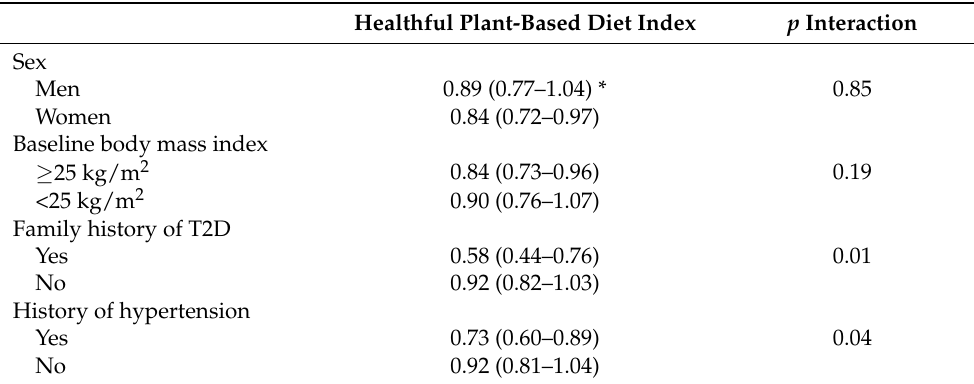
Table 4. Hazard ratios (HR) and 95% confidence intervals (CI) for incident type 2 diabetes according to the continuous hPDI score, stratified by selected